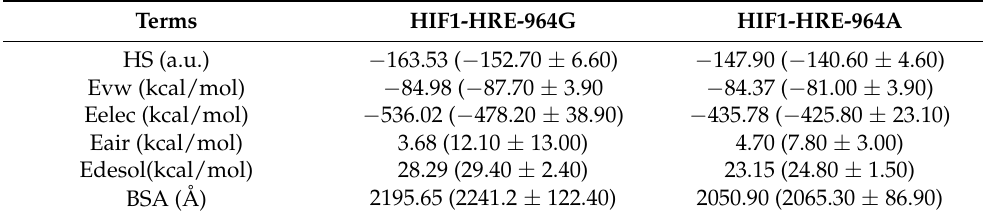
Table 2. Binding energy terms values comparison between the HIF1-HRE-964G and HIF1-HRE-964A complexes generated by